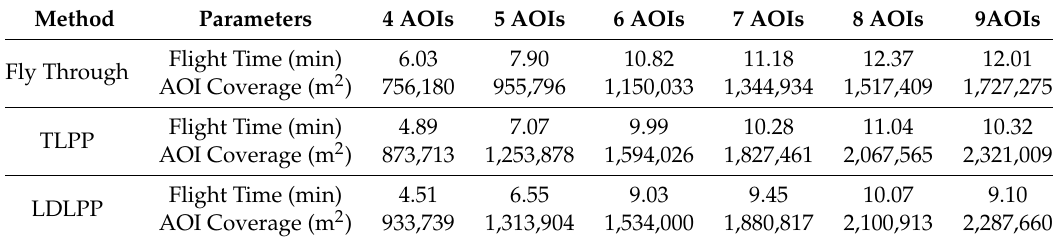
Table 1. Simulation results.